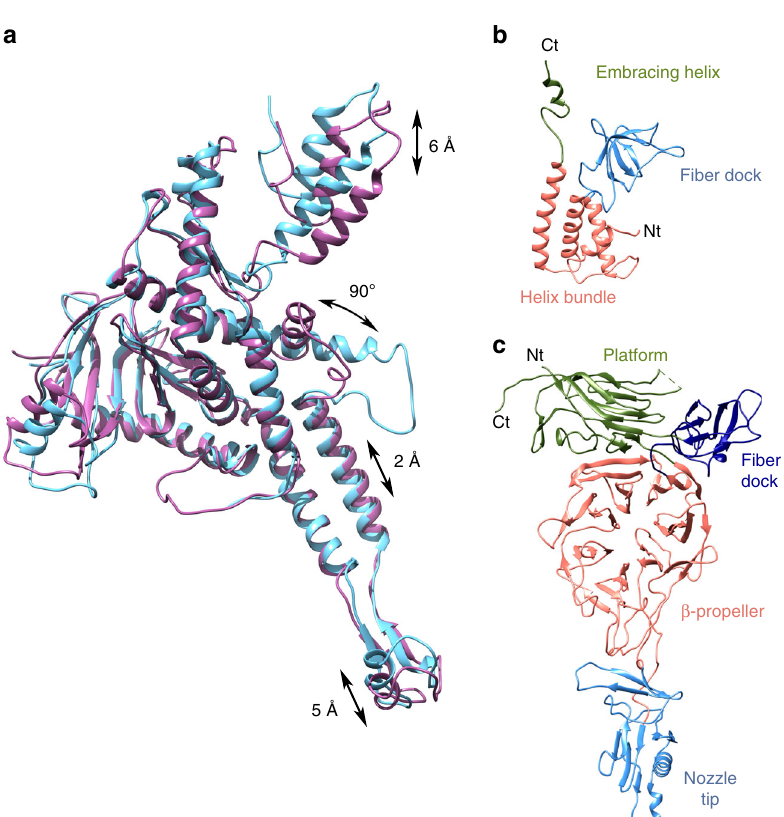
Fig. 3 Atomic structures of T7 tail proteins. a Superposition of the gp8 open as in the tail complex (orchid purple) and gp8 closed (blue) portal monomers. Distances and angles of the moving regions are indicated. b Ribbon representation of gp11 adaptor protein monomer. The different domains are colored and labeled. c Ribbon representation of gp12 nozzle protein monomer. The different domains are colored and